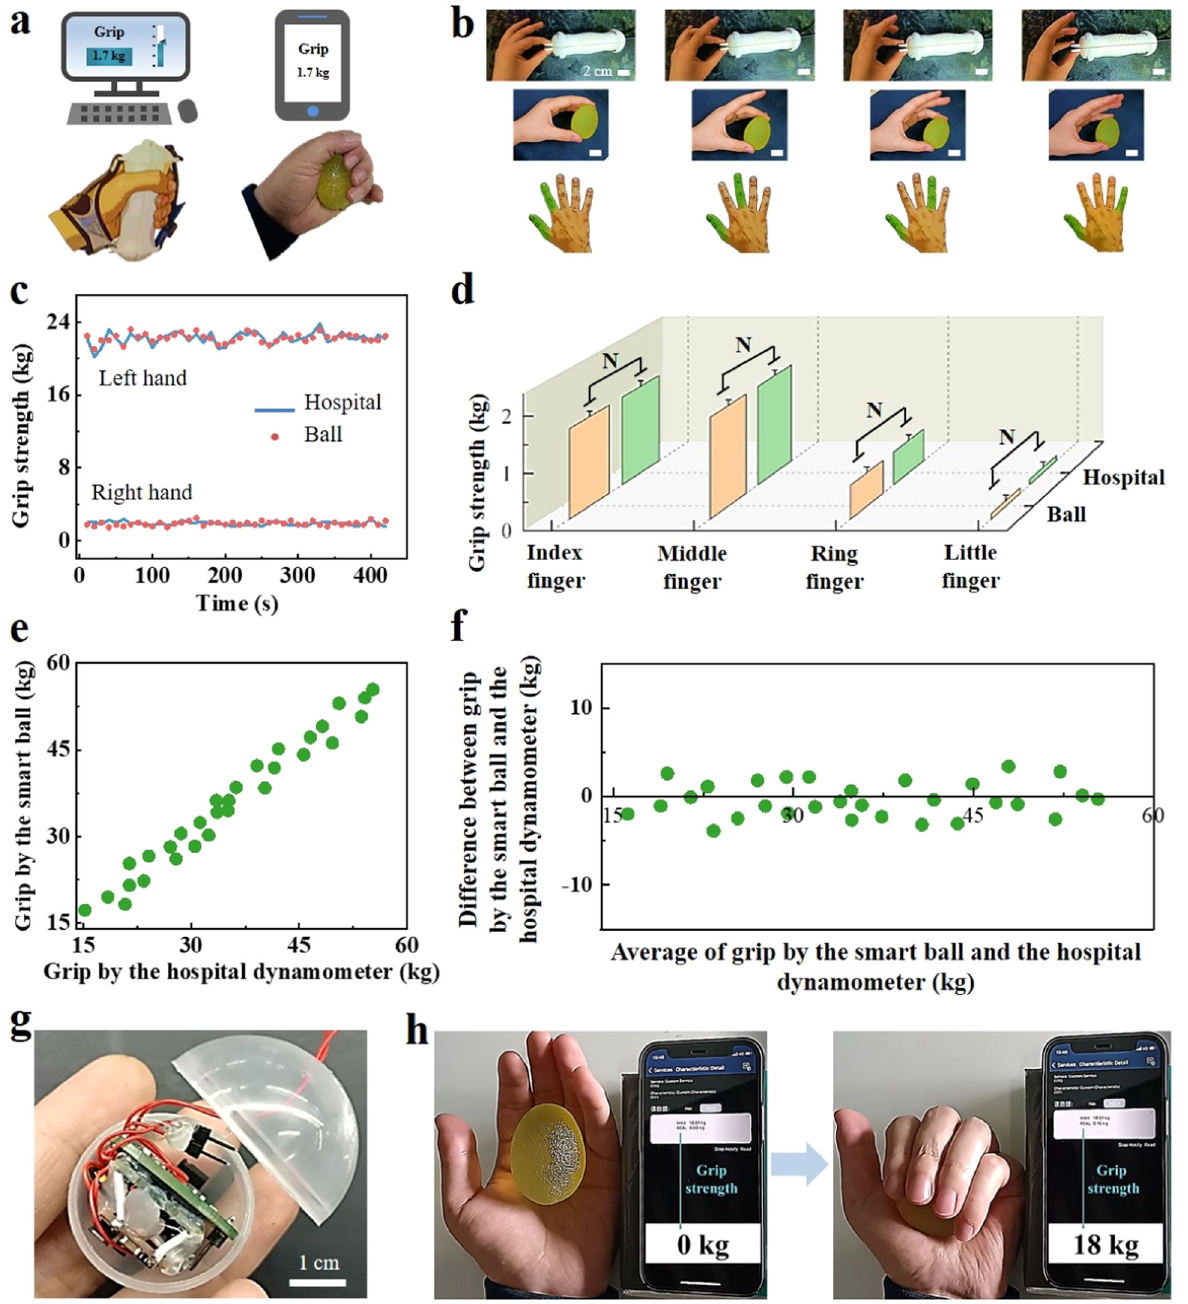
Fig. 6 On-body validation for adults. a Schematic of a hand dynamometer (hospital grip instrument) read with a computer and the smart ball sensor read with a cellphone. b Finger strength measurement using hospital grip instrument and our smart ball sensor. Comparison between a hospital grip instrument and the proposed smart ball sensor in grip strength of c palm and d four fi ngers of a stroke patient. e Relationship between the smart ball sensor and hospital grip instrument. The correlation coef fi cient of the results acquired by the two devices is 0.92. f A Bland – Altman plot of the smart ball sensor and hospital grip instrument. Here all the grip strength means the maximum value. g A digital photo of a pill shell fi lled with all the electronic accessories. h Photos of the maximum grip strength of a healthy man monitored by the smart ball sensor and read with a accurate grip strength measurement for children. While our smart ball sensor with all the electronic accessories embedded in the center of the soft elastic ball (Fig. 6g), can realize continuous monitoring, wireless transmission and readout with a cellphone (Fig. 6h). It is especially suitable for children ’ s grip monitoring.